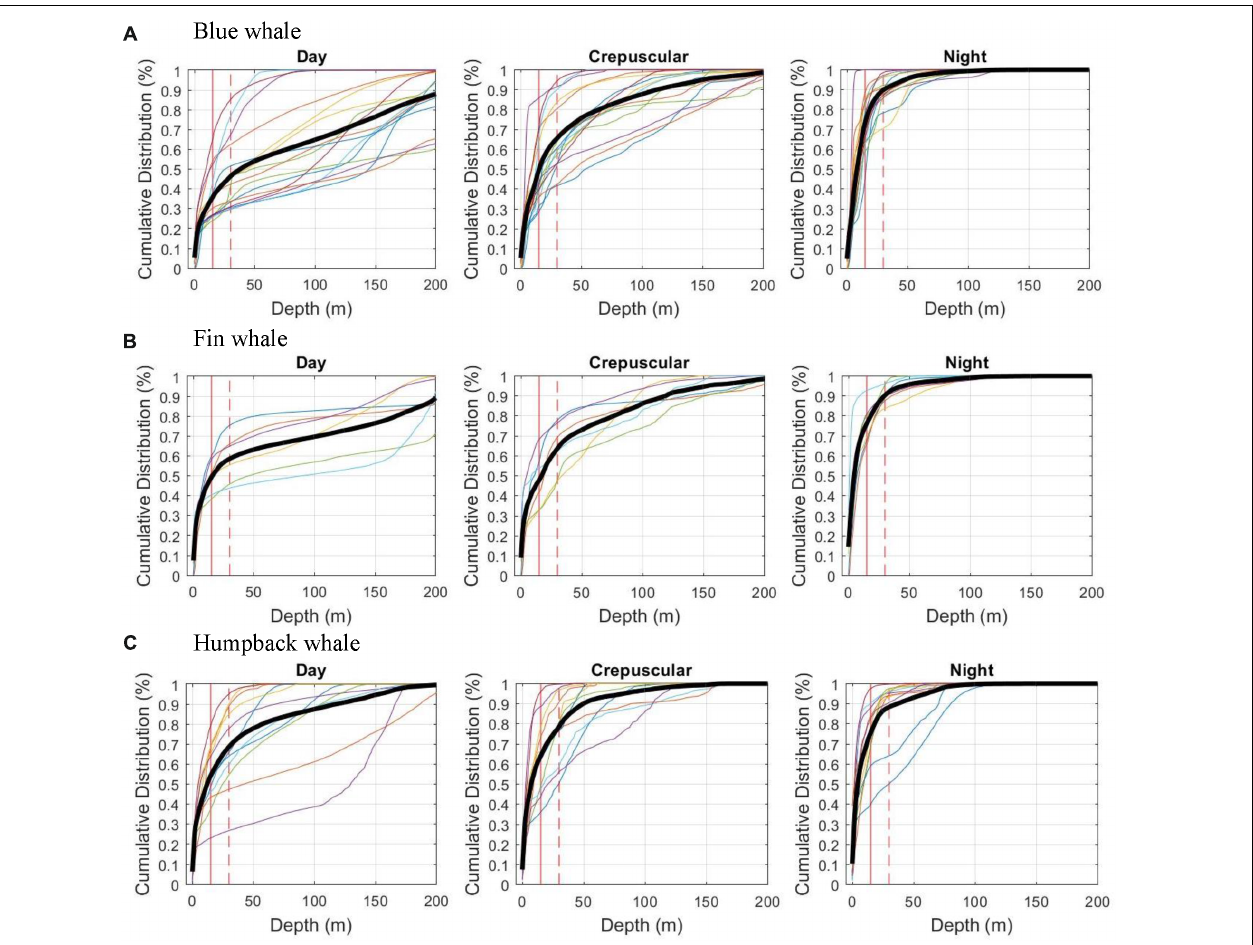
FIGURE 2 | Cumulative time at depth and shallower by species and broken into 3 periods (day, crepuscular, and night). The 9 plots (3 species and 3 time periods) show cumulative time on Y axis and depth on X axis showing faint tracings for each individual deployment and bold tracing showing average for all deployments on that species in that time period. These represent time periods where the animal was along the US West Coast and exclude migrating animals. Average for each species/period weights each individual equally (treating long deployments with equal weight as shorter ones). Vertical lines show 15 and 30 m depths as discussed in Methods. (A) Blue whale Day Night, (B) Fin whale, and (C) Humpback